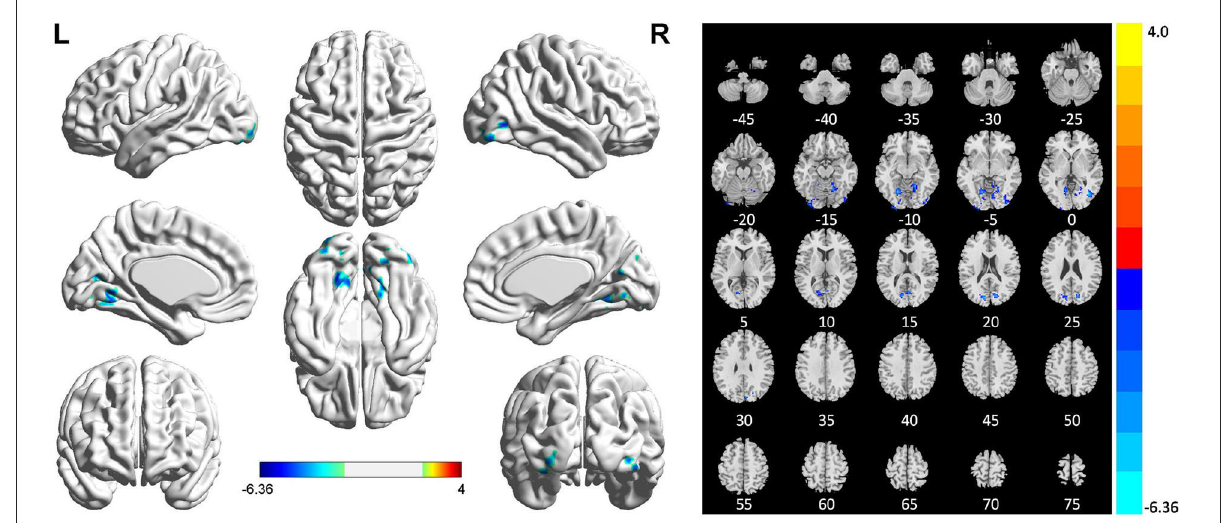
FIGURE4 Statistically significant differences between post-stroke insomnia (PSI) patients and healthy controls are shown in the fractional amplitude of low-frequency fluctuation (fALFF) map of the whole brain with magnetic resonance imaging (MRI). Patients with PSI showed a significant